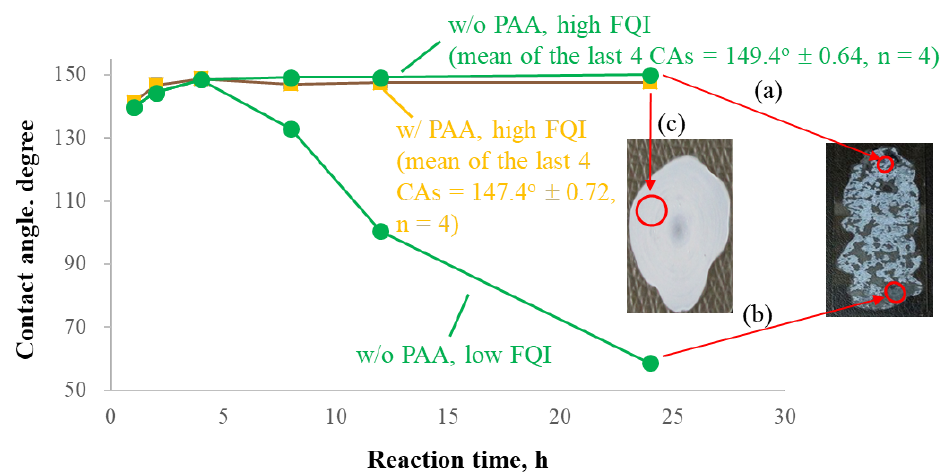
Figure 7. CAs at various film surface after 24 h of sol aging time: ( a ) film area without PAA; ( b ) hole area without PAA; ( c ) film area with PAA.